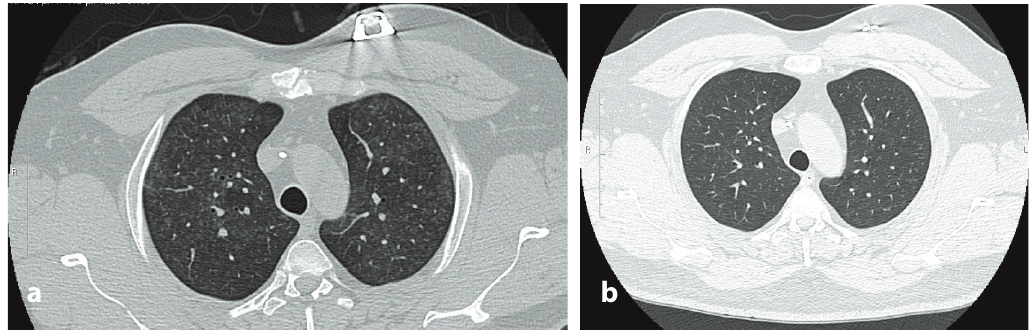
Figs 5a and 5b. Axial CT images before and after steroid therapy.